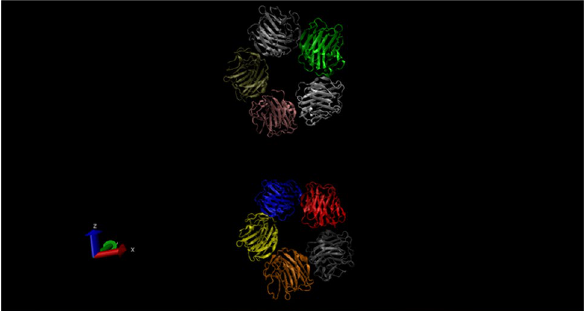
Figure 1. Pentameric structure of C-reactive protein obtained using the Visual Molecular Dynamics (VMD) software 2 .